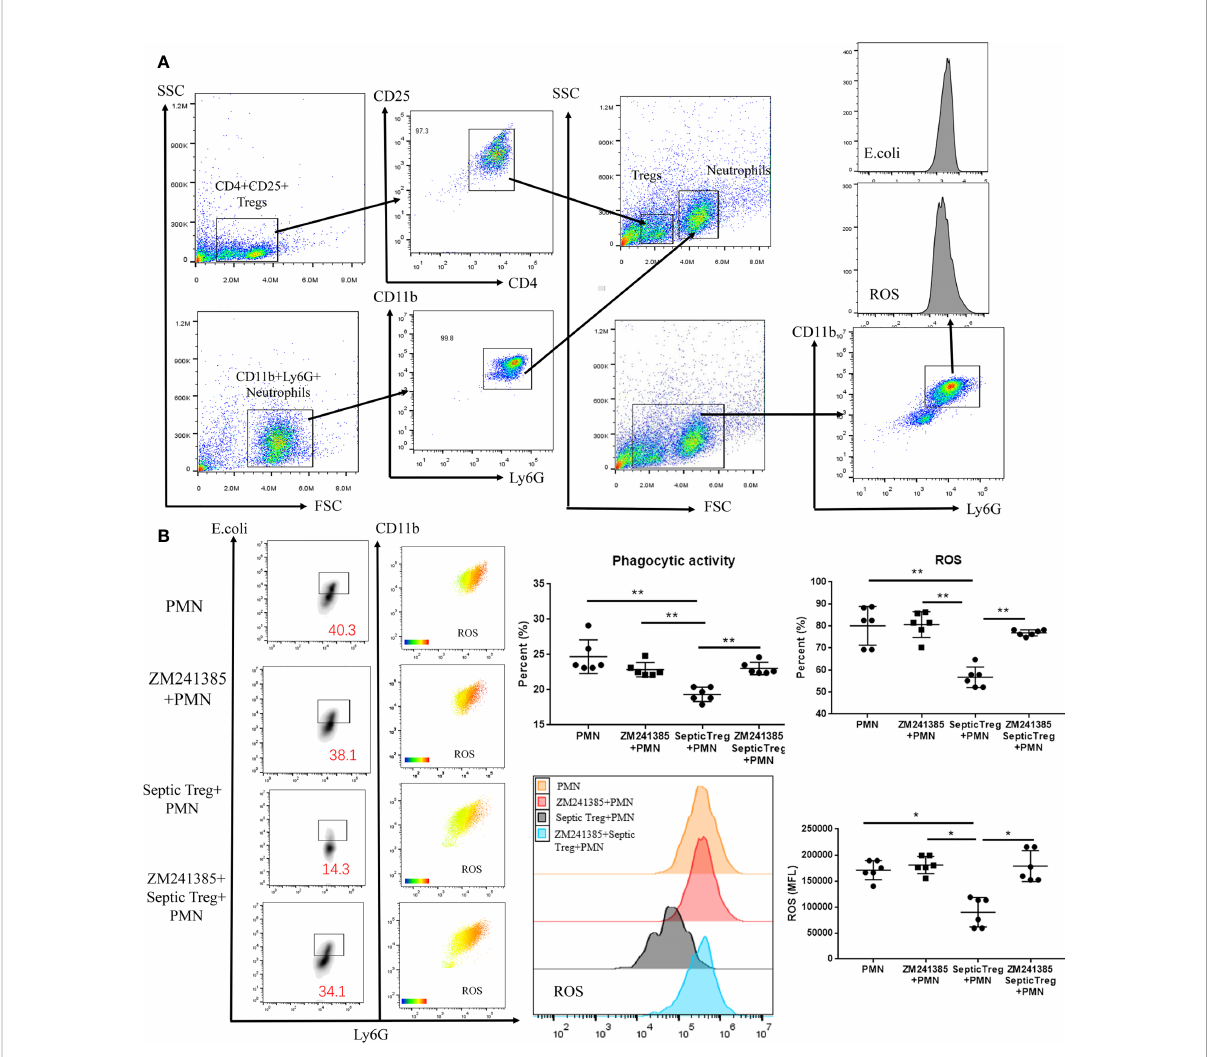
FIGURE 5 ZM241385 in fl uenced Treg-mediated inhibition of neutrophil phagocytosis and ROS generation in vitro. CD4+CD25+ Tregs and CD11b+Ly6G+ neutrophils were isolated by FACS using the FACSAria IIu instrument. The purity of Treg and neutrophil populations assessed by 2-color fl ow cytometry was >95%. (A) Neutrophils were co-cultured with septic CD4+CD25+ Tregs and their phagocytic capacity or ROS generation ability was evaluated as previously described. (B) We found that neutrophil phagocytosis and ROS generation could be inhibited by septic Tregs and restored by ZM241385. * p < 0.05, ** p <